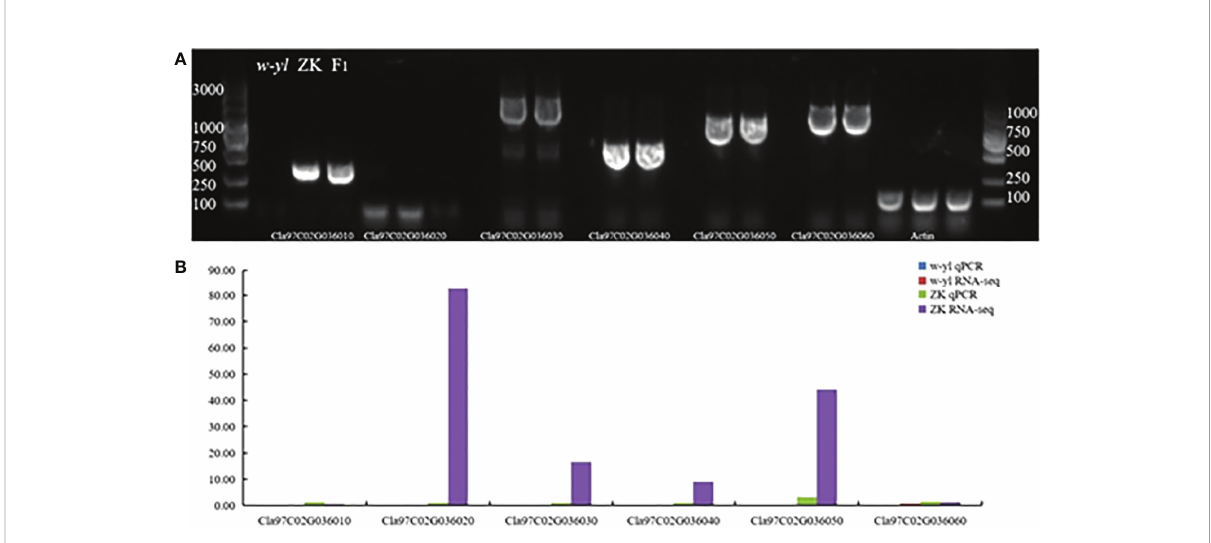
FIGURE 7 Ampli fi cation of candidate genes Cla97C02G036010, Cla97C02G036020, Cla97C02G036030, Cla97C02G036040, Cla97C02G036050 and Cla97C02G036060